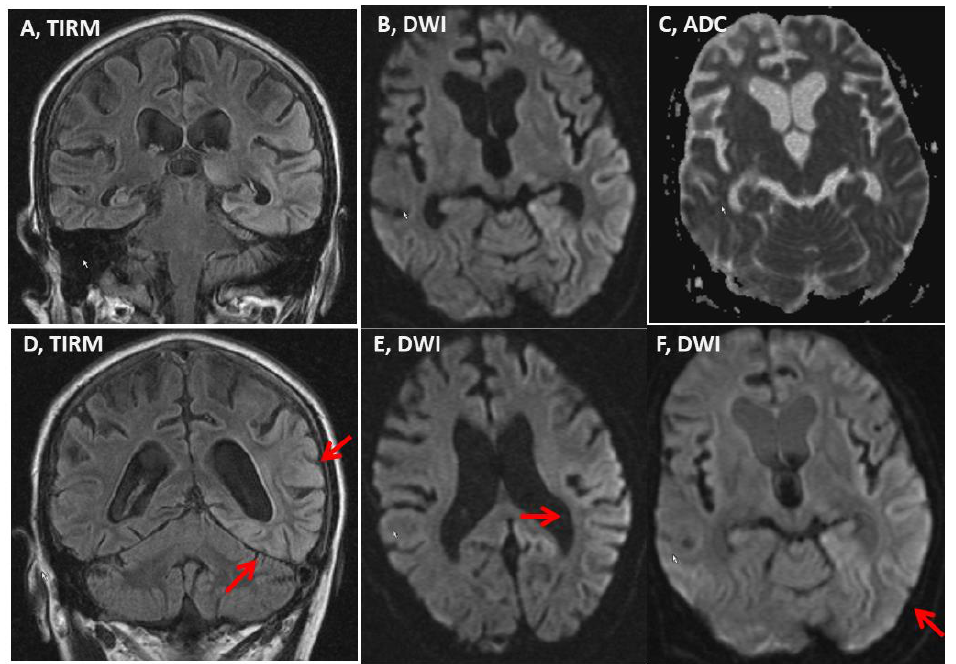
Figure 1. Magnetic resonance imaging (MRI) of the brain carried out on hospital day 13 showing a T2 and diffusion weighted imaging DWI hyperintense lesion in the left occipito-temporal region and the median left thalamus (panels A , B , D , E , F ), which were slightly hypointense on apparent diffusion coefficient (ADC) (panel C ). The MRI findings were unchanged compared to those on hospital day 1 and hospital day 3.